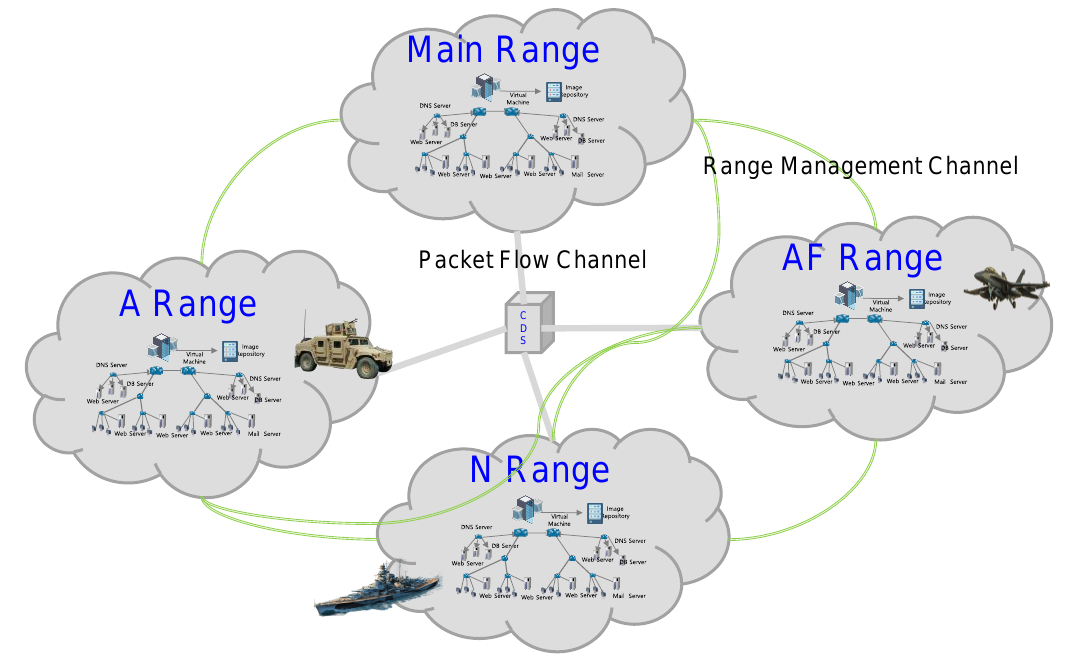
Figure 2. Networking architecture for connecting ranges.